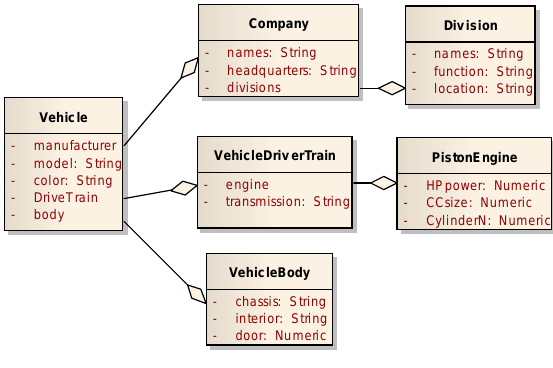
Figure 1. An example of a nested object